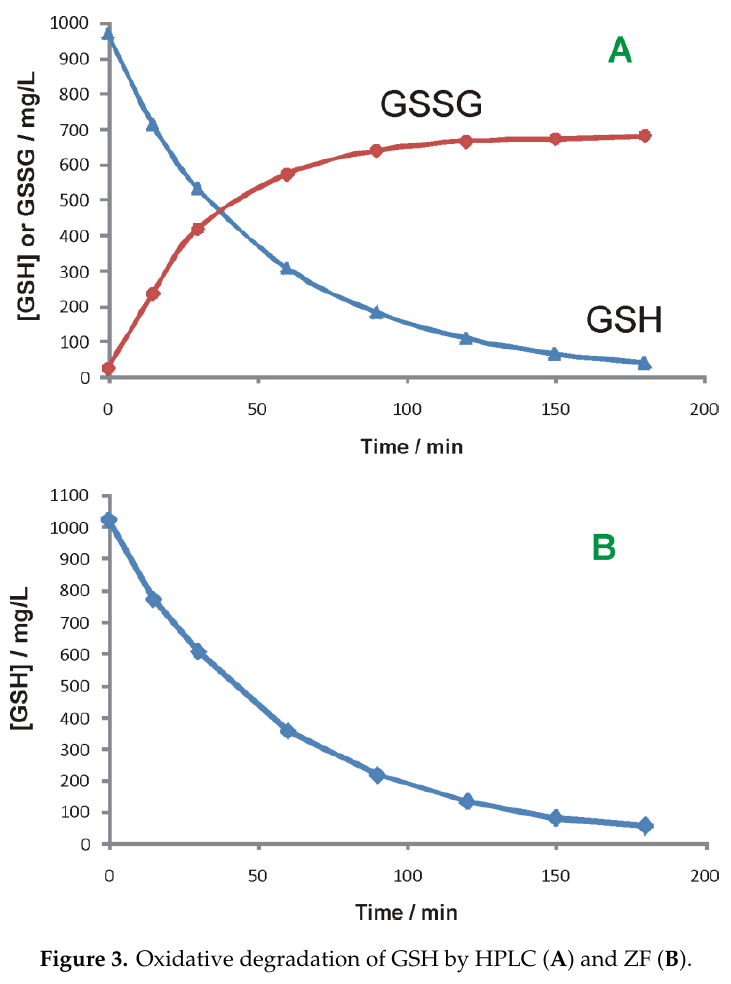
Figure 3. Oxidative degradation of GSH by HPLC ( A ) and ZF ( B ).